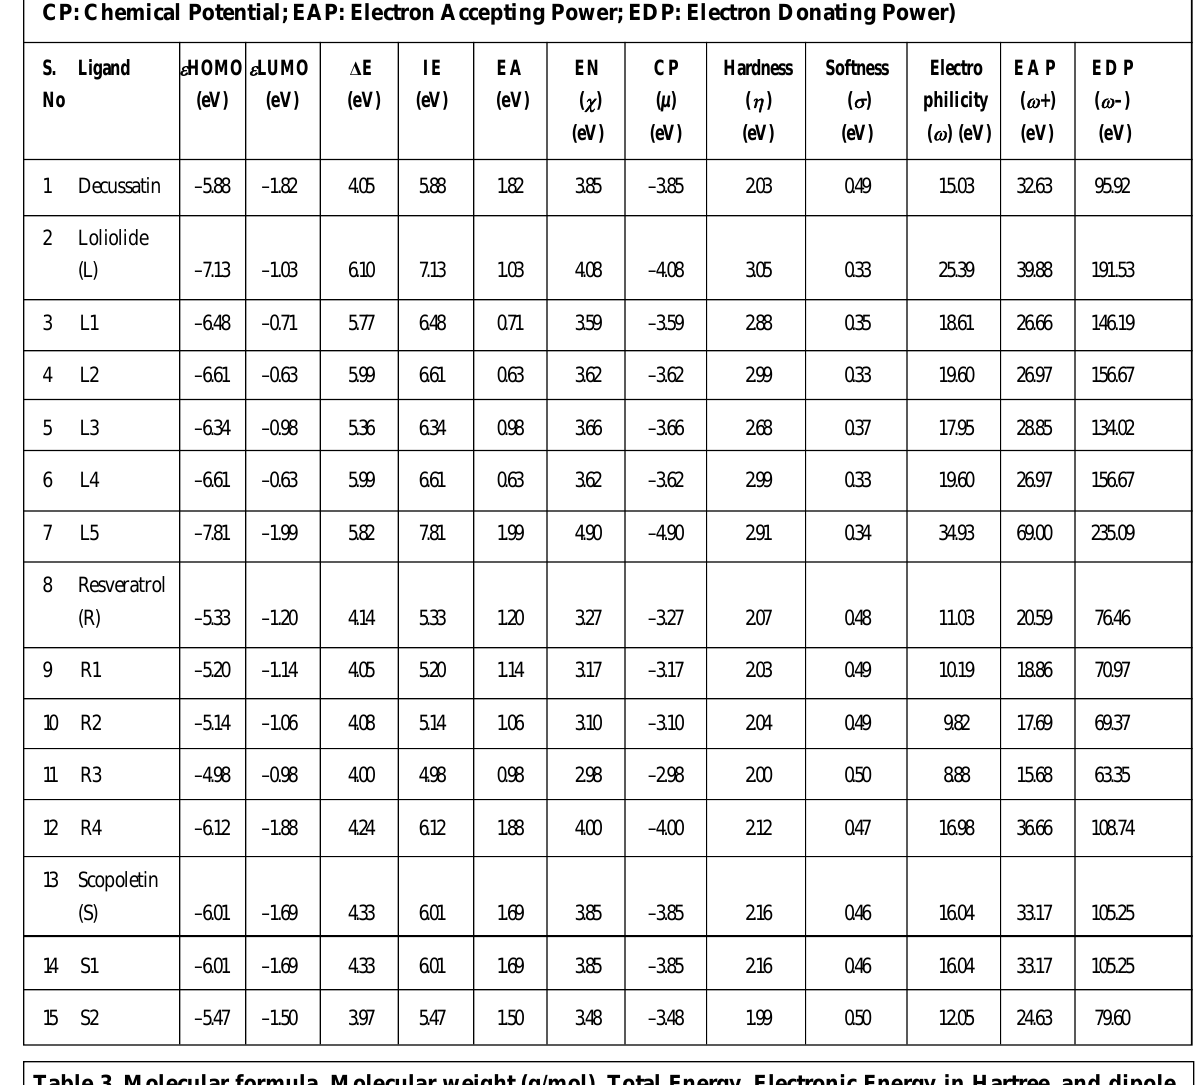
Table 3. Molecular formula, Molecular weight (g/mol), Total Energy, Electronic Energy in Hartree, and dipole moment (Debye) of the studied polypharmacological phytochemicals and its modified derivatives.